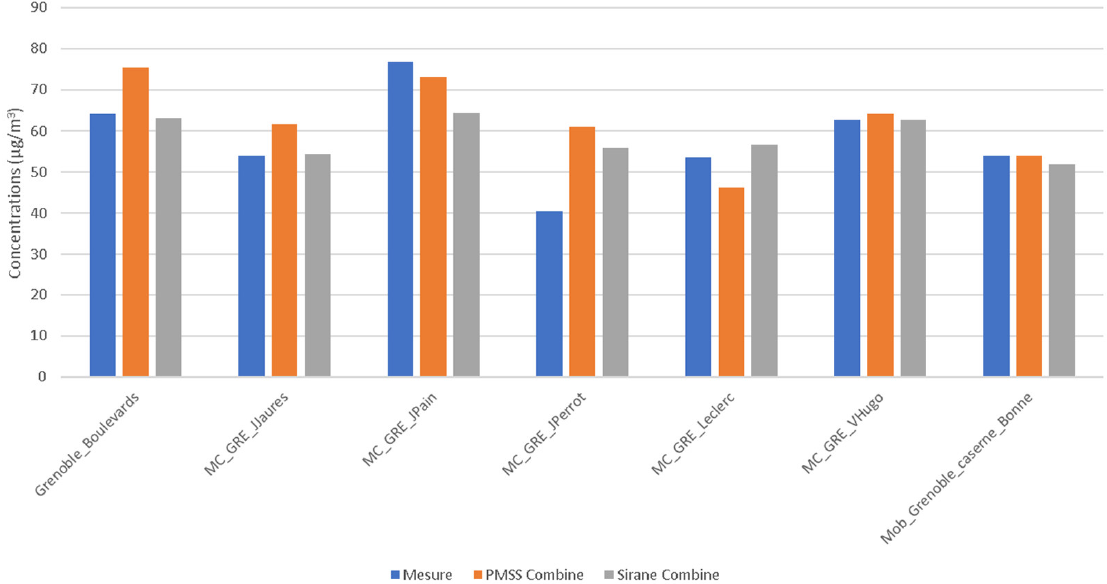
Figure 5. Average NO 2 concentrations during the period from the 15th of January 2017 to the 31st of January 2017 at measurements points—Observation in blue, PMSS model in orange, and SIRANE model in grey.